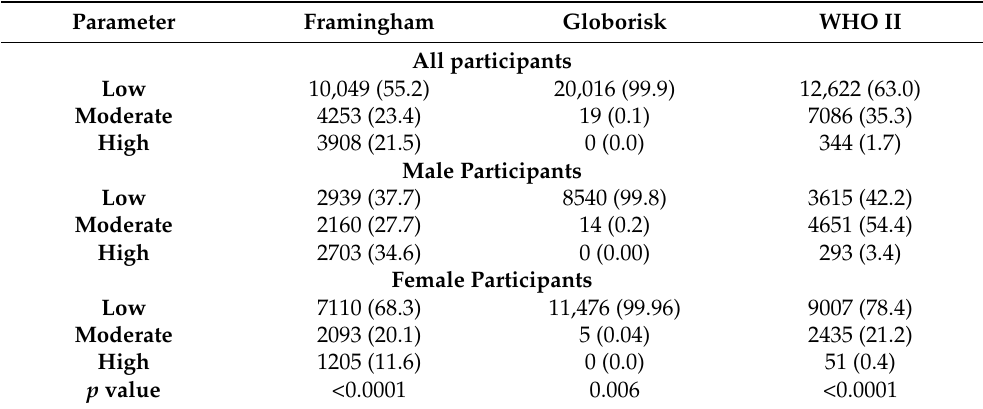
Table 4. CVD risk classification among the population living in the Netherlands using nonlaboratory- based Cardiovascular risk